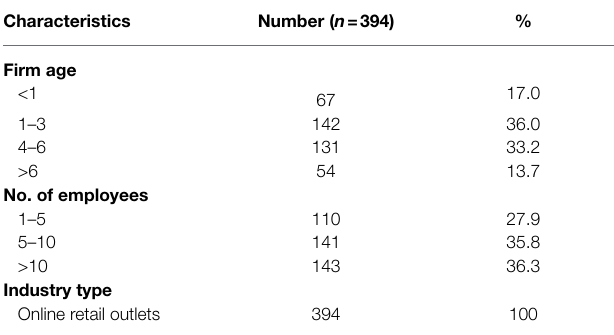
TABLE 3 | Characteristics of the